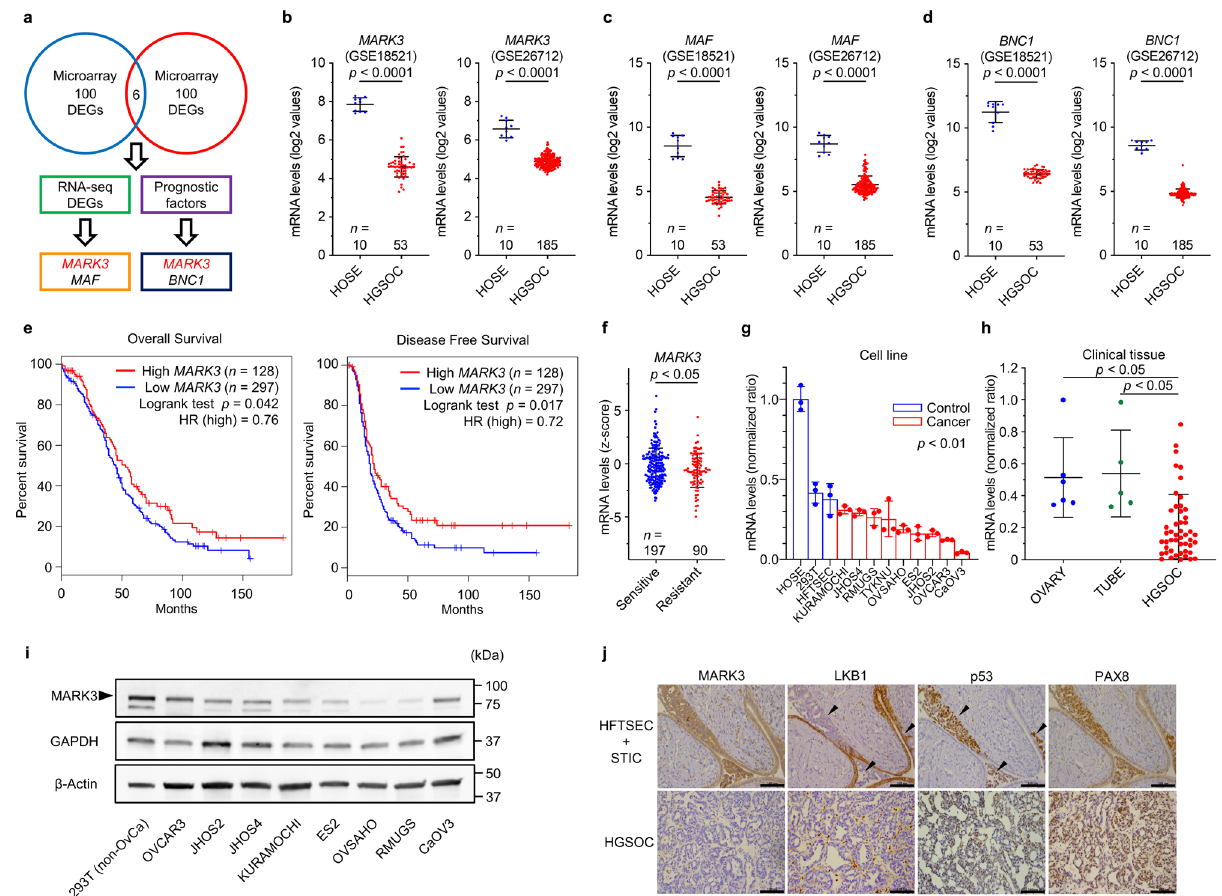
Fig. 1 Downregulation of MARK3 is associated with poor clinical outcome in patients with HGSOC. a Schematic of in silico integrative analysis to identify HGSOC-associated dysregulated genes. MARK3 is downregulated in HGSOCs across two microarray datasets and one RNA-seq data set, and low MARK3 mRNA expression is associated with poor clinical outcomes in the TCGA HGSOC cohort. b – d mRNA expression levels of MARK3 ( b ), MAF ( c ), and BNC1 ( d ) in two independent microarray datasets. GSE18521 and GSE26712 offer microarray data of human ovarian surface epithelial cell (HOSE) samples and HGSOC samples [GSE18521(HOSE: n = 10, HGSOC: n = 53) and GSE26712 (HOSE: n = 10, HGSOC: n = 185)]. Statistical analysis was performed using an unpaired Student ’ s t -test. e Kaplan – Meier survival curves classi fi ed by high ( n = 128) or low ( n = 297) MARK3 mRNA expression in the TCGA HGSOC cohort. Low MARK3 group exhibits poor overall survival (left) and poor disease-free survival (right). f Platinum-resistant HGSOCs ( n = 90) have lower MARK3 mRNA expression compared to platinum-sensitive HGSOCs ( n = 197). Error bars represent mean ± standard deviation (SD). Statistical analysis was performed using an unpaired Student ’ s t -test. g , h RT-qPCR shows that MARK3 expression is downregulated in ovarian cancer cell lines [comparison between control ( n = 3) and ovarian cancer cell line ( n = 9)] ( g ) and the HGSOC tissues [ovary ( n = 6), fallopian tube ( n = 5) and HGSOC ( n = 49)] ( h ). Ovarian cancer cell lines with HGSOC-like genetic pro fi le, such as TP53 mutation and hyper CNA are included in this experiment. Error bars represent mean ± SD from three biological replicates. Statistical analysis was performed using an unpaired Student ’ s t -test. i Immunoblotting shows that MARK3 expression is downregulated in ovarian cancer cell lines compared to that in 293T cells (non-OvCa; non-Ovarian Carcinoma). j Immunohistochemistry displays that MARK3 is ubiquitously expressed in human fallopian tube secretory epithelial cells (HFTSECs) and serous tubal intraepithelial carcinomas (STICs), whereas its expression is diminished in primary HGSOCs. The expression of LKB1 is clearly decreased in STICs (arrow). p53 is used as a positive marker for STICs (arrow) and HGSOCs. Scale bars, 100 μ